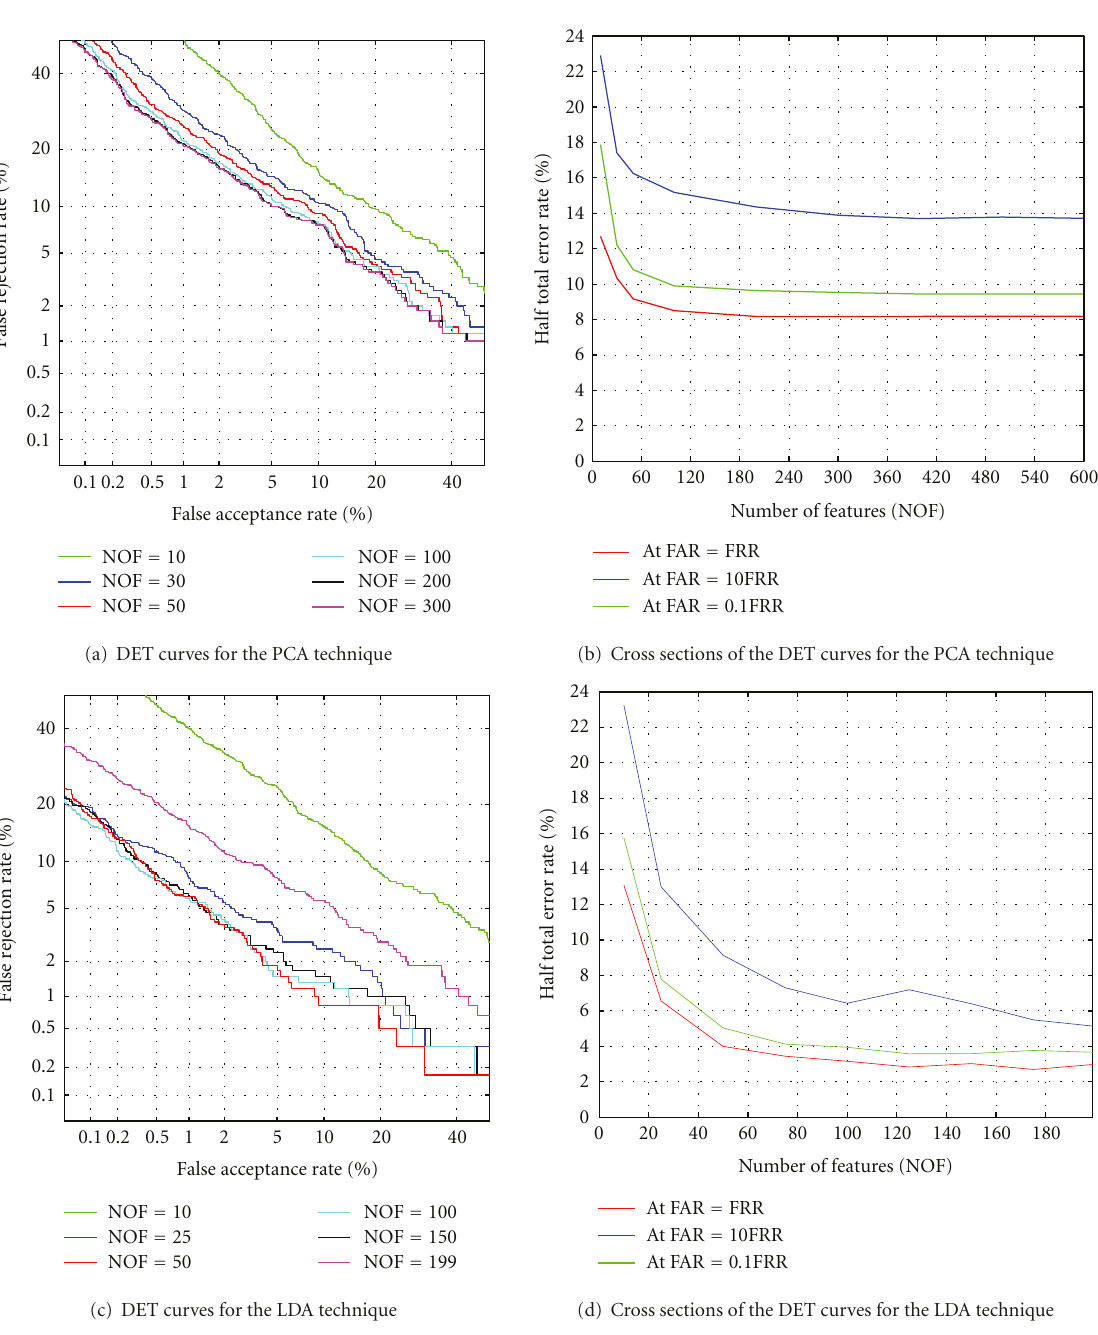
Figure 14: Results of the face verification experiments on the XM2VTS database for varying lengths of the PCA and LDA feature vectors.